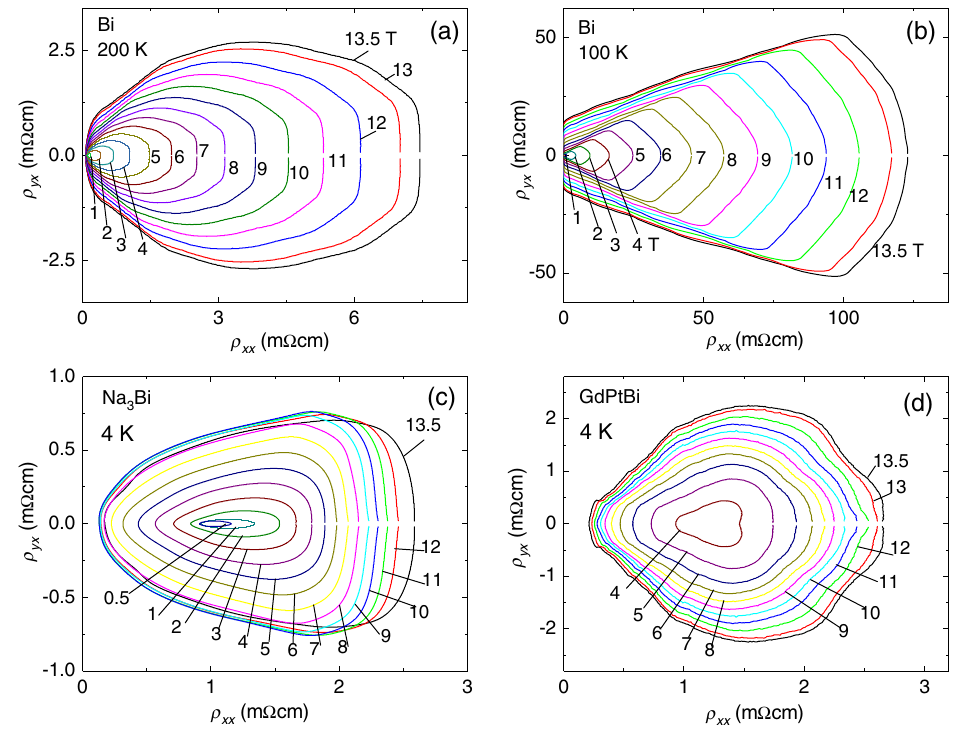
FIG. 8. Parametric plots of the planar AMR signals. Panel (a) shows the orbits in pure Bi at 200 K (sample B2) obtained by plotting ρ xx vs ρ yx with θ as the parameter and with B kept fixed. The orbits start at the left (small ρ xx ) and end at the right (large ρ xx ). As B increases, the orbits expand without saturation to the right. Panel (b) shows the same plots measured at 100 K. The increased mobility strongly amplifies the lopsided expansion pattern, which resembles a shock wave. The orbits in the parametric plots measured in Na 3 Bi (sample N2, at 4 K) and GdPtBi (G1) at 2 K [panels (c) and (d), respectively] are nominally concentric around the point at B ¼ 0 . The differences between case 1 and case 2 reflect the very different behaviors of ρ xx at the extreme angles θ ¼ 0 and 90°, as discussed in Fig.